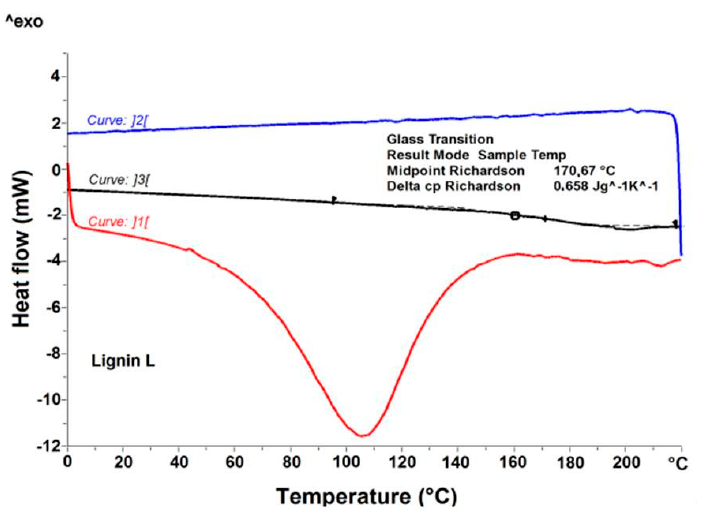
Figure 13. DSC determination of glass transition temperature (T g ) and change in heat capacity (C p )